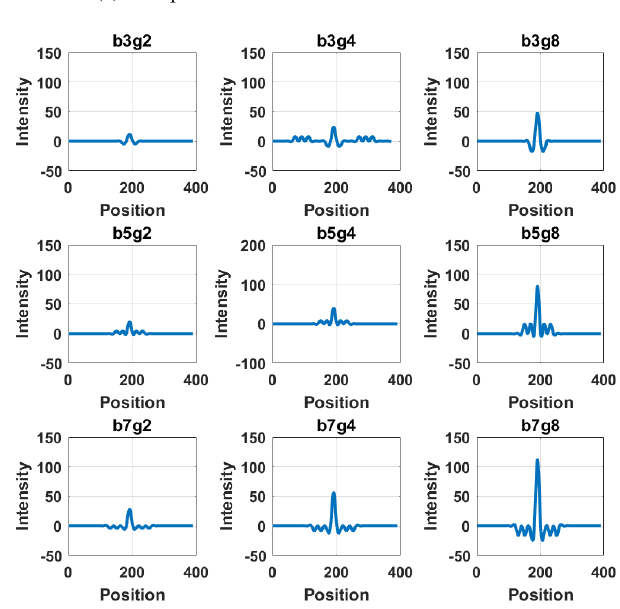
Figure 5. The theoretical analysis results. ( a ) The 3-bit Barker code combined 4-bit Golay code compared to simple pulse, 7-bit Barker code, 11-bit Barker code, 4-bit Golay code and 8-bit Golay code. ( b ) The theoretical intensity comparison of nine different sequences of BCG